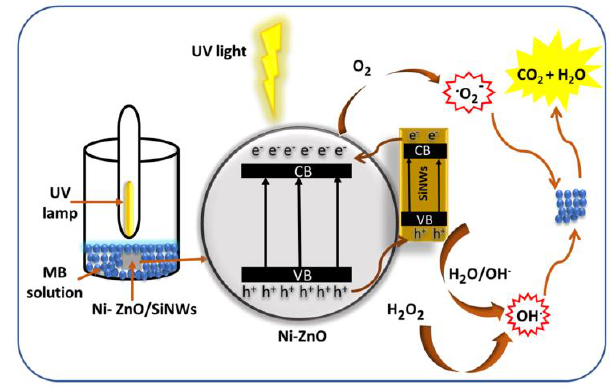
Figure 1. Photocatalysis of zinc oxide.